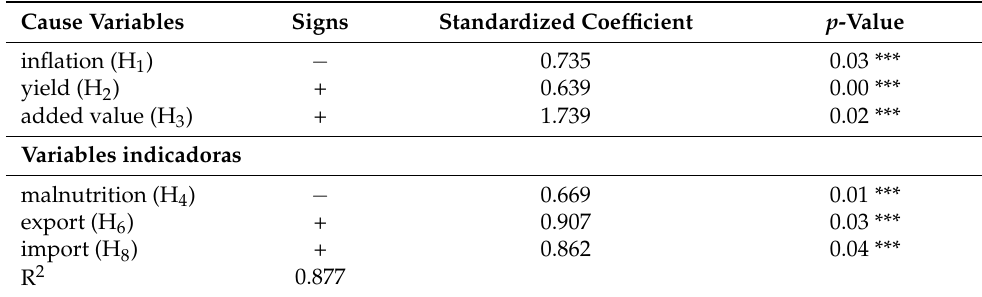
Table 4. Summary of the MIMIC